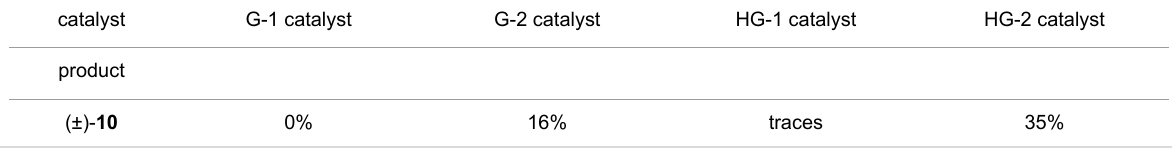
Table 3: Isolated yields for compound (±)- 10 formed in the ring-opening reaction of lactone (±)- 9 with ethylene in ROM reactions with various cata- lysts.